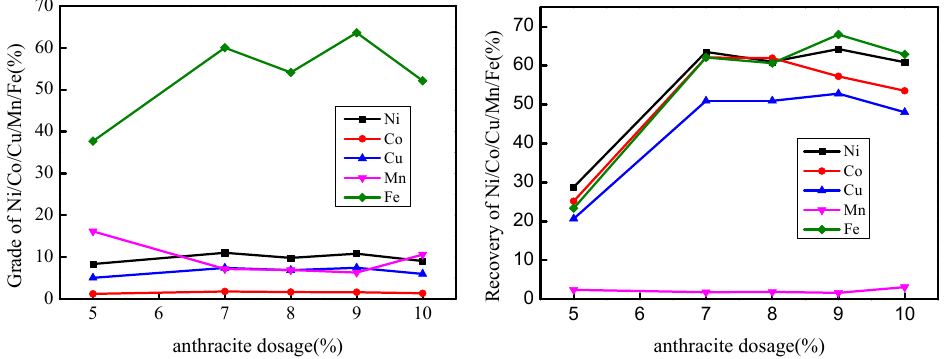
Figure 5. Effect of anthracite dosage on the concentration of valuable metals.